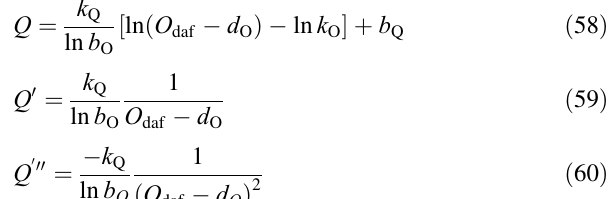
Fig. 13 Variation of O content with vitrinite reflectance R o ; max .